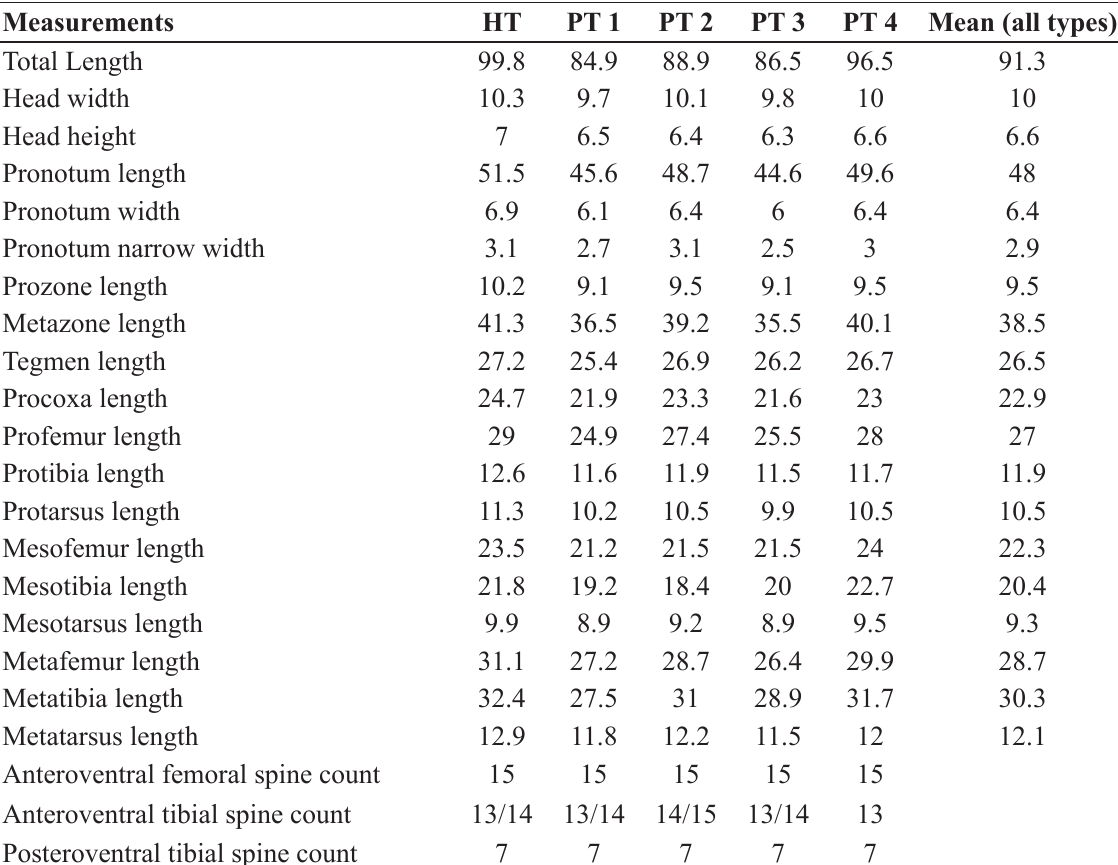
Table 1. Measurements and spine counts for the holotype (HT) and the 4 paratypes (PT) of Phasmomantella nuichuana gen. et sp. nov., placed in the same order as in Measurements